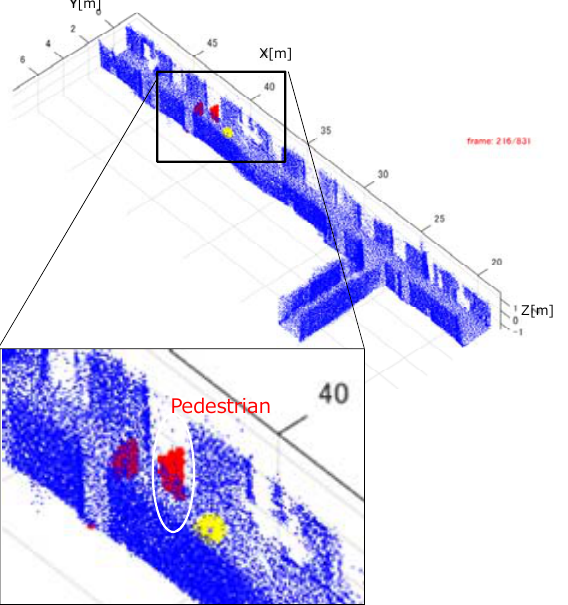
Figure 15. Estimated distances from iBeacon transmitters to the iBeacon